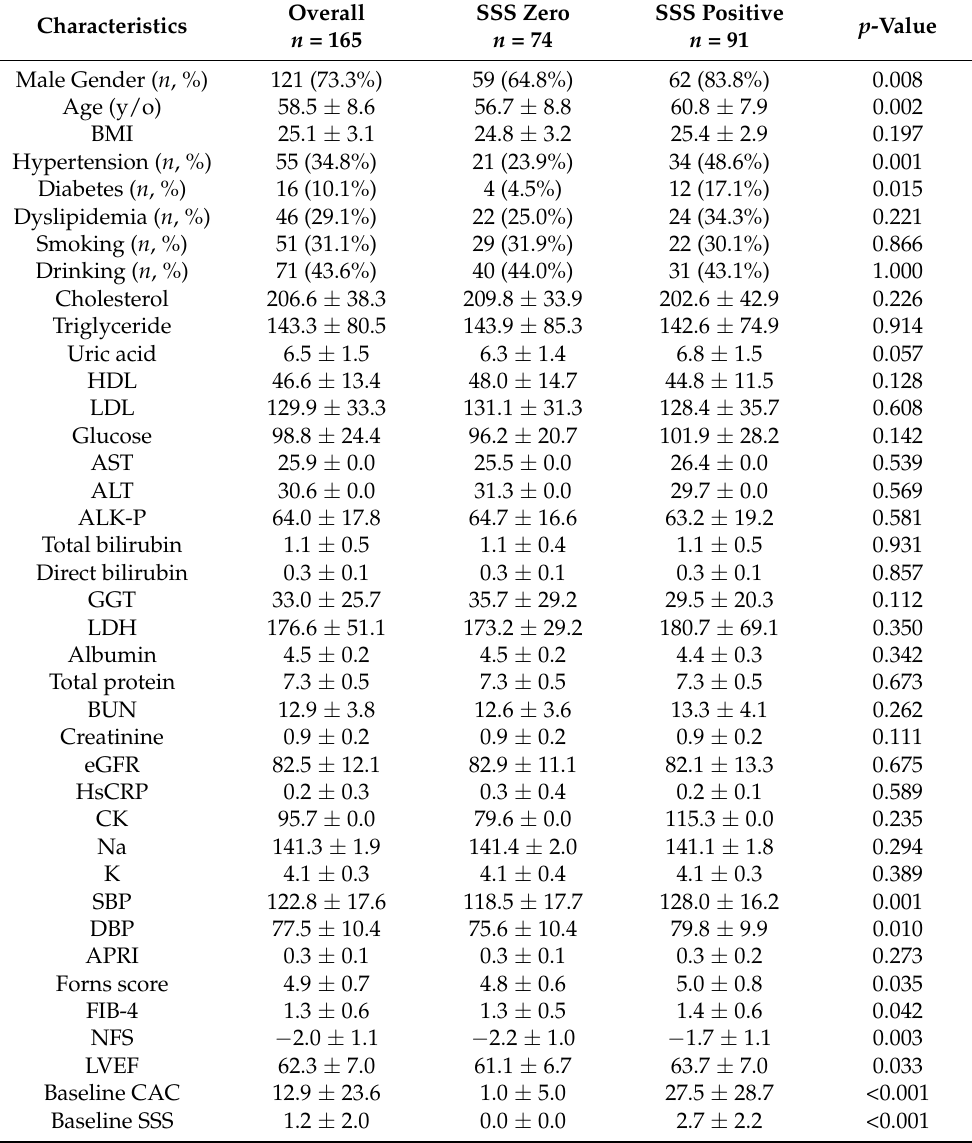
Table 1. Baseline characteristics of low-risk patients with and without initial SSS ( n = 165).